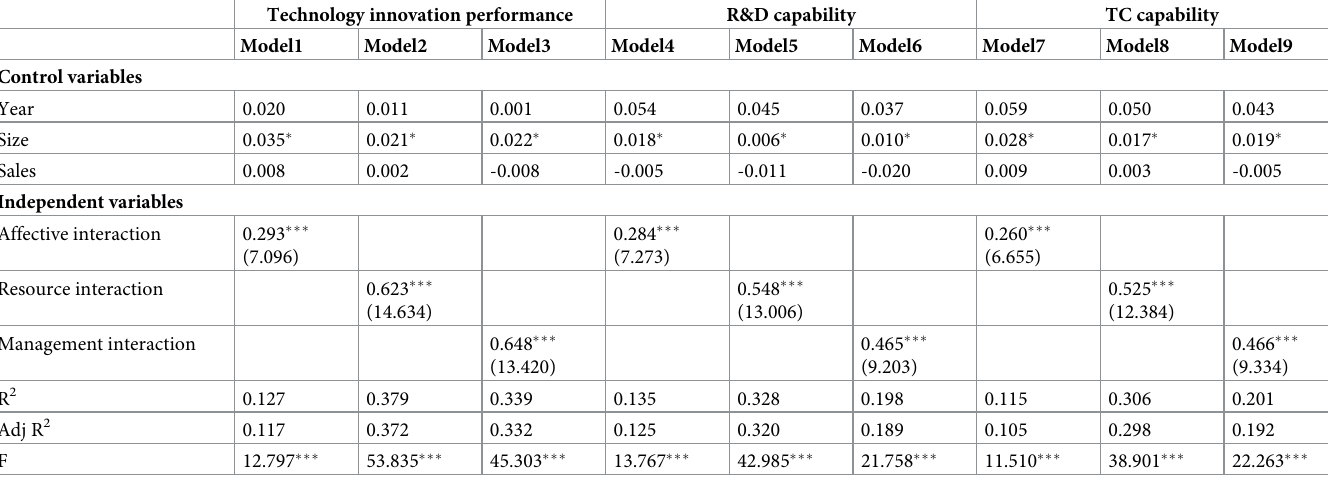
Table 4. Results of enterprise interaction and technological innovation performance, technological innovation